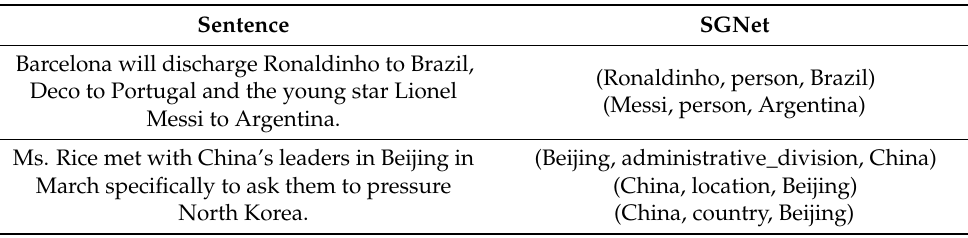
Table 4. Case study for SGNet.